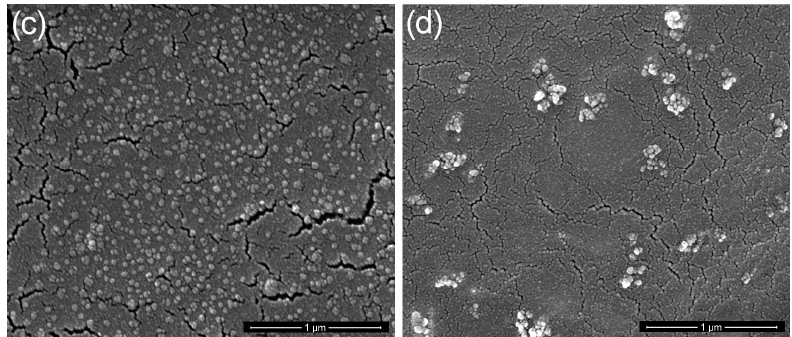
Figure 12. Scanning electron microscopy (SEM) images of ( a ) neat polyurethane coating, ( b ) raw TiO 2 /PU-6 nanocomposite coating, ( c ) TiO 2 -HBP/PU-6 nanocomposite coating, and ( d ) TiO 2 -HBP/PU- 8 nanocomposite coating.